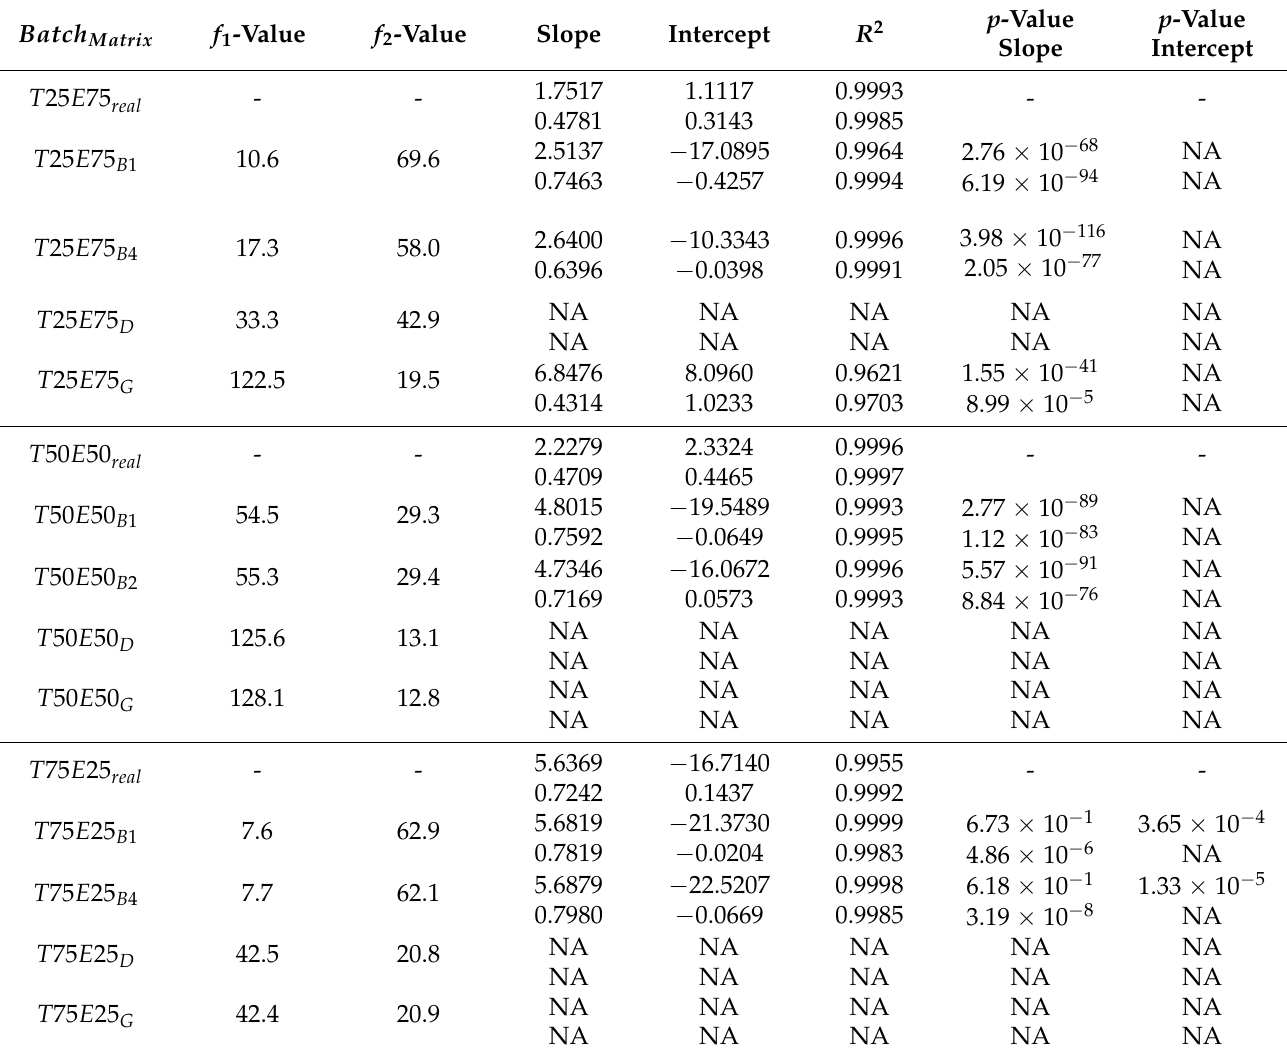
Table A3. The calculated results of the comparison of the predicted dissolution profiles and the experimental one. The first row in a cell is the value of the Higuchi plot, the second row represents the value of the Korsmeyers–Peppas plot. ’NA’ indicates that a value was not calculated because either there were too few data points or it was not necessary, e.g., if the slopes were significantly different, the p -value of the axis intercept was not